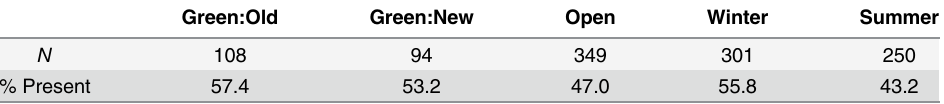
Table 1. The number of observations N with each of the attributes and the percentage of these obser- vations where snapper presence was